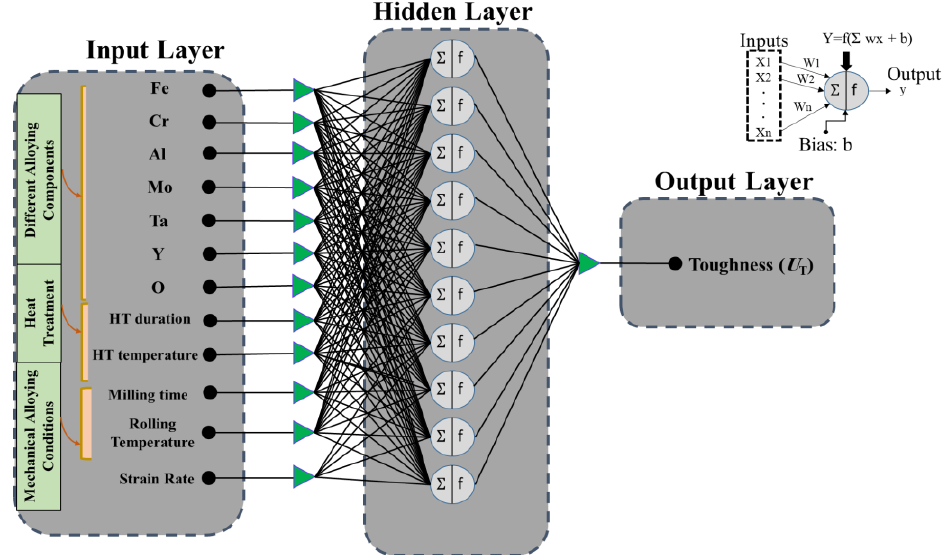
Figure 2. Typical structure for the ANN model used in this study [32].